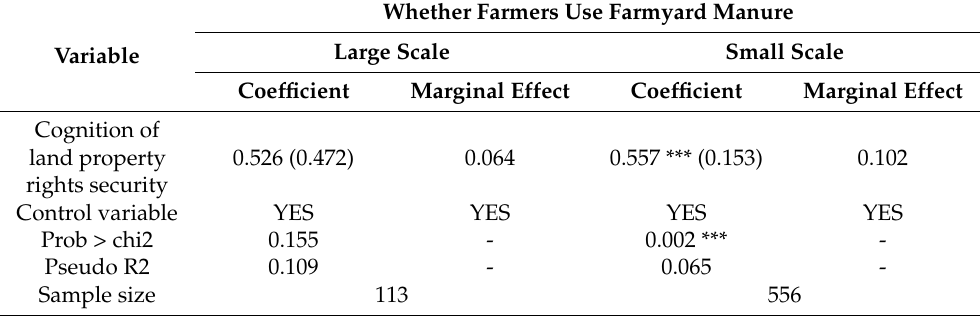
Table 6. Comparative analysis of farmers with different land scales.